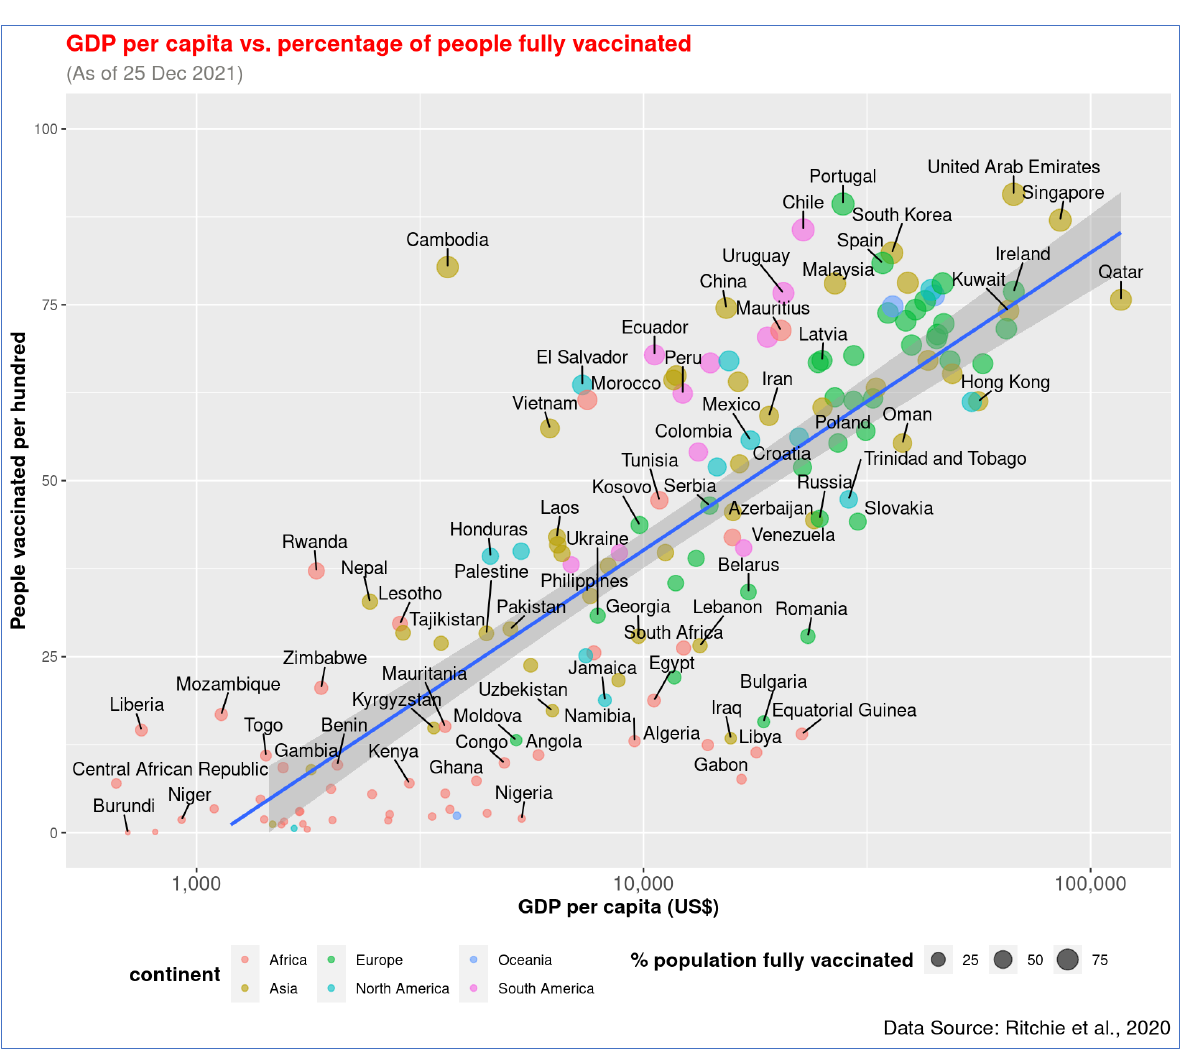
Figure 2. Association of GDP per capita and COVID-19 full vaccination rate across countries. The relationship of both partial and full vaccination rates with GDP is similar.